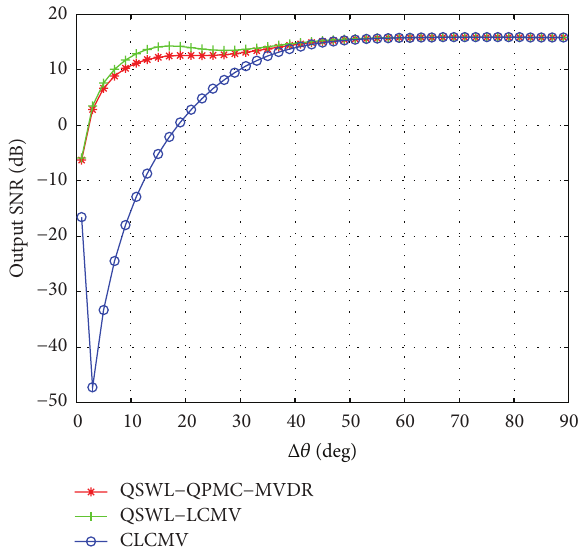
Figure 3: Effect of the angular separation Δ𝜃 between the interfer- ence and the desired